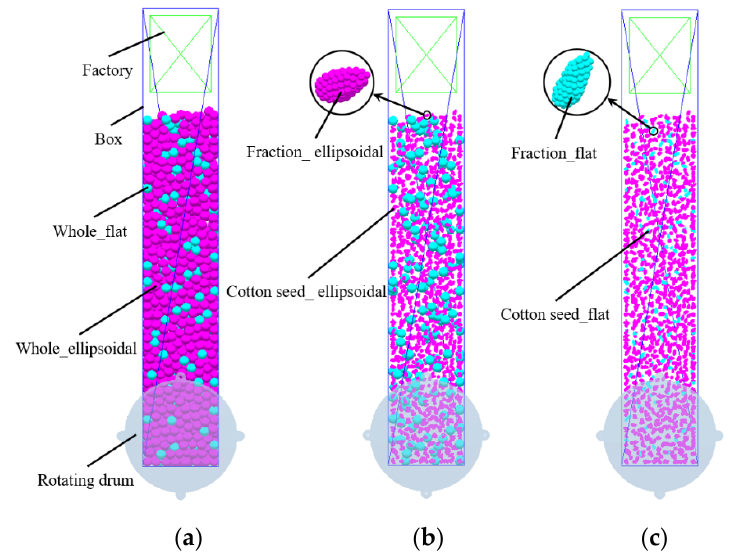
Figure 8. Generation process of cotton seeds discrete element models. ( a ) Whole_ellipsoidal and Whole_flat particles generation; ( b ) ellipsoidal cotton seeds generation; ( c ) flat cotton seeds generation.